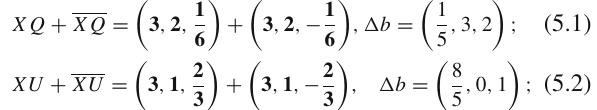
Table 5 D6-brane configurations and intersection numbers of Model 3, with its gauge coupling relation is g 2 a = 5